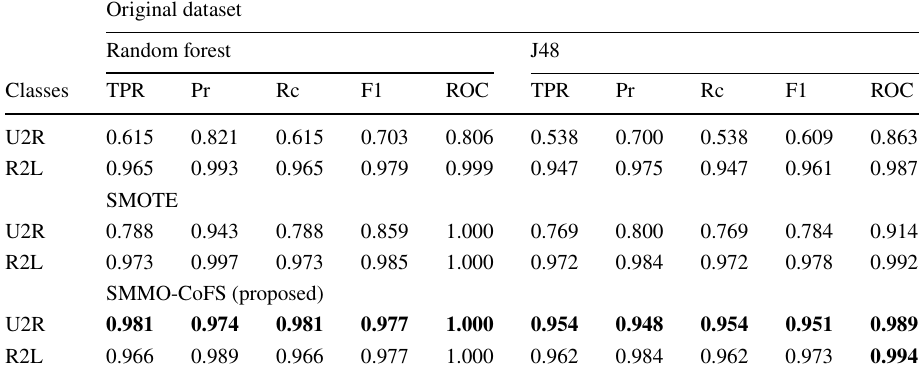
Bold values indicate the best results obtained